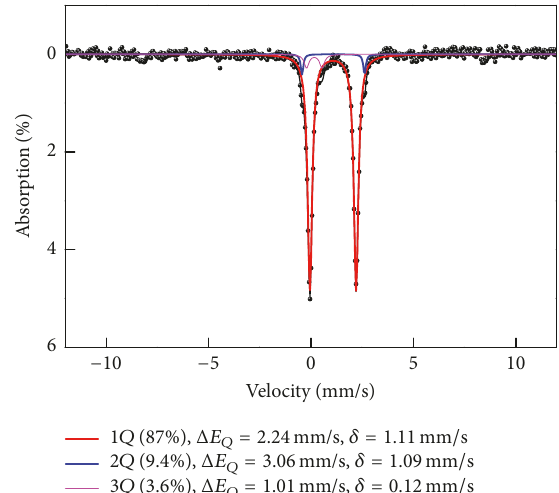
Figure 3: M¨ossbauer spectroscopy to study an industrial sample Dynabi tablet including ferrous fumarate and ferrous